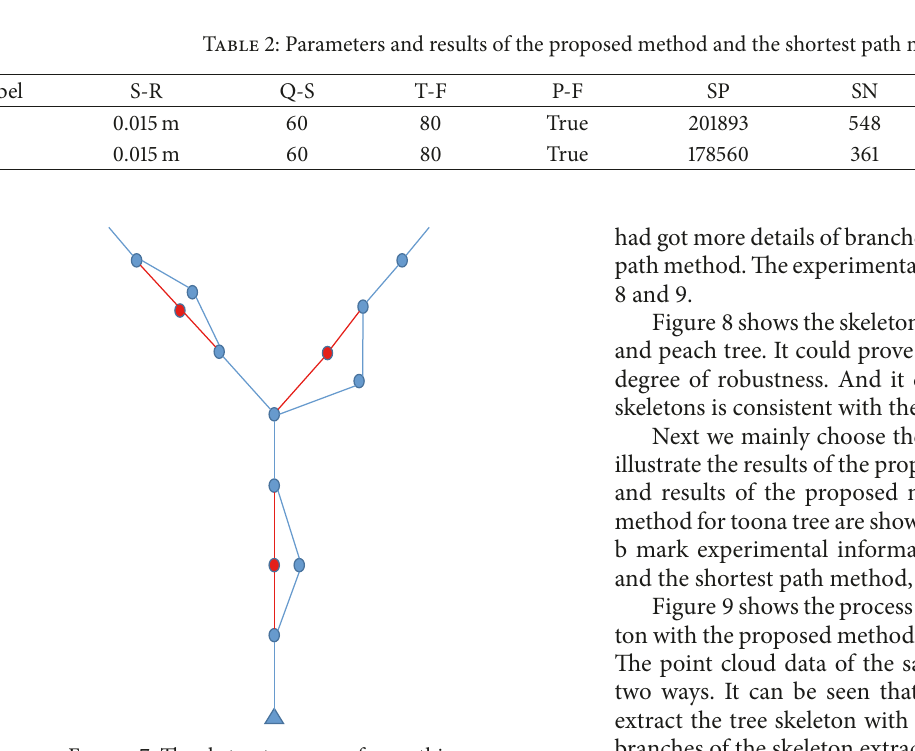
Figure 7: The abstract process of smoothing.